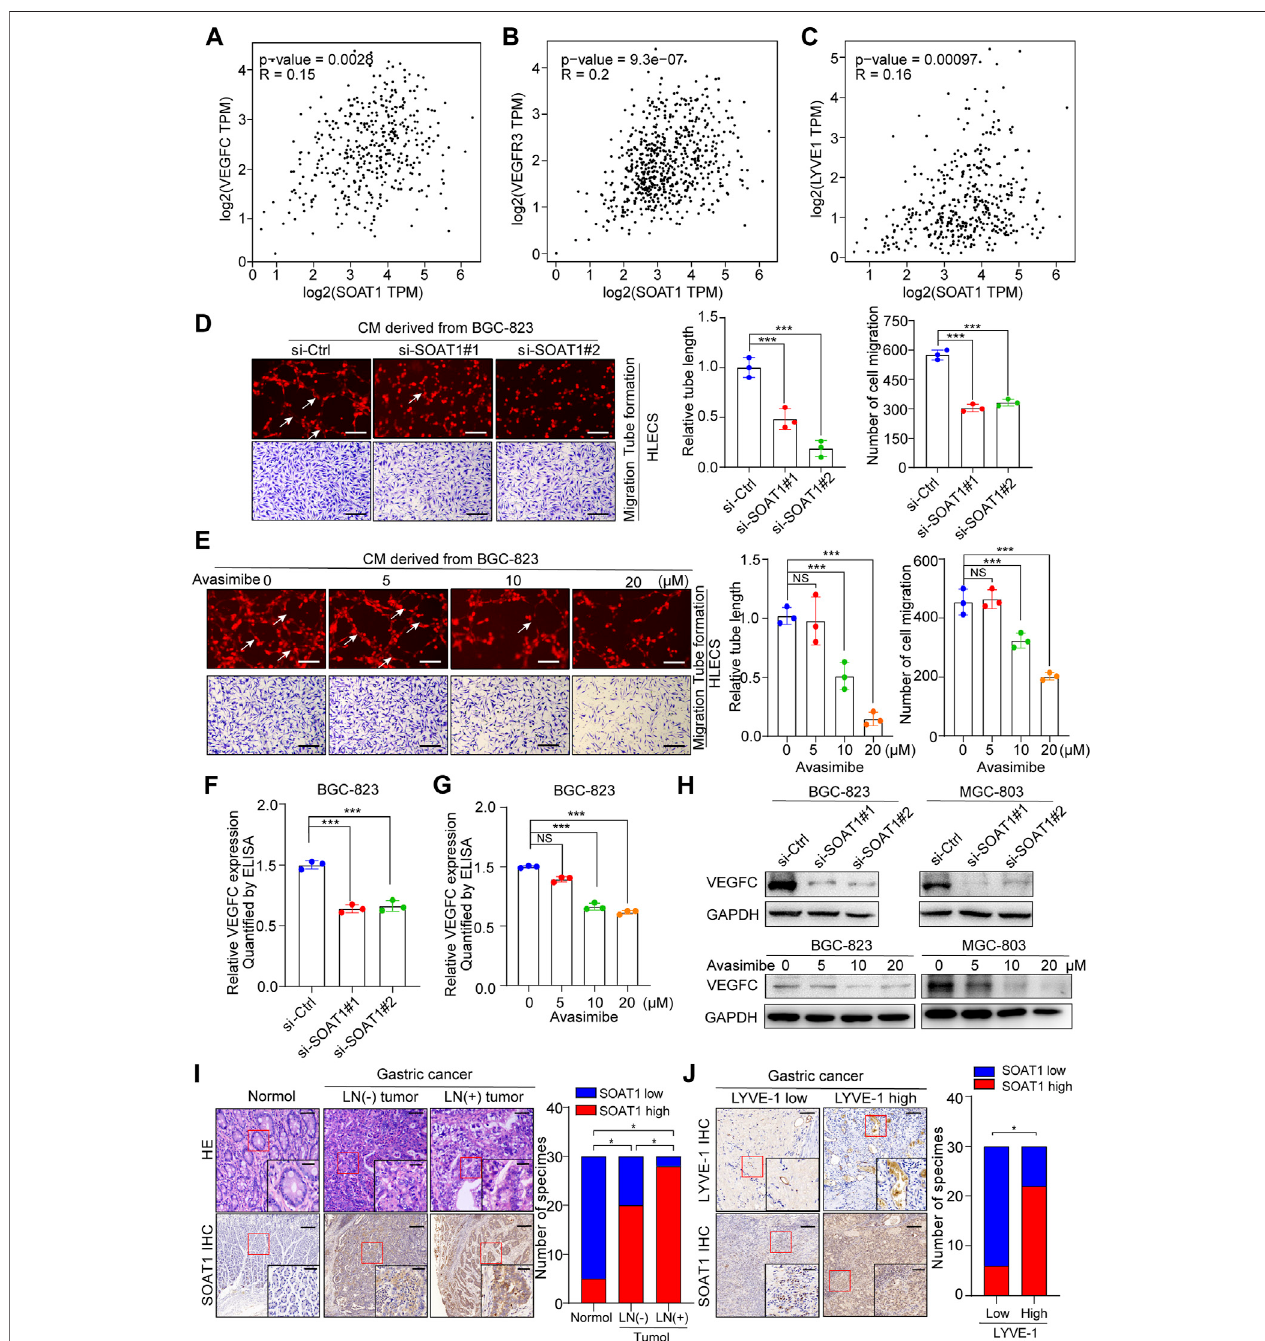
FIGURE 6 | SOAT1 promotes lymphangiogenesis and lymph node metastasis in GC. (A – C) The correlation of SOAT1 expression with VEGFC, VEGFR3, and LYVE-1 were analyzed via online bioinformatics tool (http://gepia.cancer-pku.cn/). (D,E) Representative images (left panel) and quantitative analysis (right panel) of tube formation and transwell migration assays of HLECs cultured with conditioned medium collected from SOAT1-knockdown (D) or avasimibe-treated (E) BGC-823 cells. Scale bars: 100 µm (F,G) ELISA assay of VEGFC expression in conditioned medium collected from the SOAT1 knockdown or avasimibe treated BGC-823 cells. (H) VEGFCexpression at theprotein levelin BGC-823 and MGC-803 cellsweremeasuredbywesternblotassay after knockdown ofSOAT1 oravasimibetreatment. (I) Representative images (left panel) and quantitative analysis (right panel) of SOAT1 IHC staining in paraf fi n-embedded paired normal tissues, sections of tumors with or without LNM from patients with GC. Scale bars: 200 µm and 50 μ m, respectively. (J) Representative images (left panel) and quantitative analysis (right panel) of SOAT1 IHC staining in high or low levels of LYVE-1-positive microvessels in the GC tissues. Scale bars: 200 µm and 50 μ m, respectively.